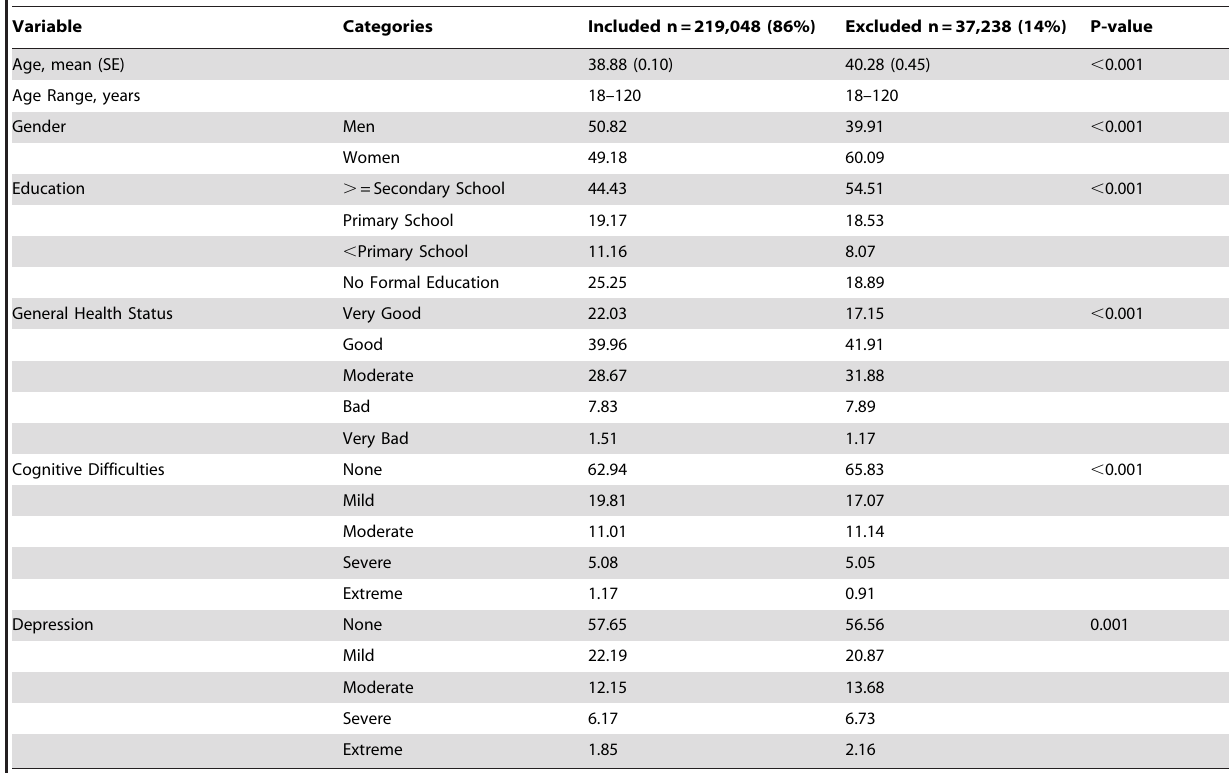
Table 1. Descriptive characteristics of those included and excluded from